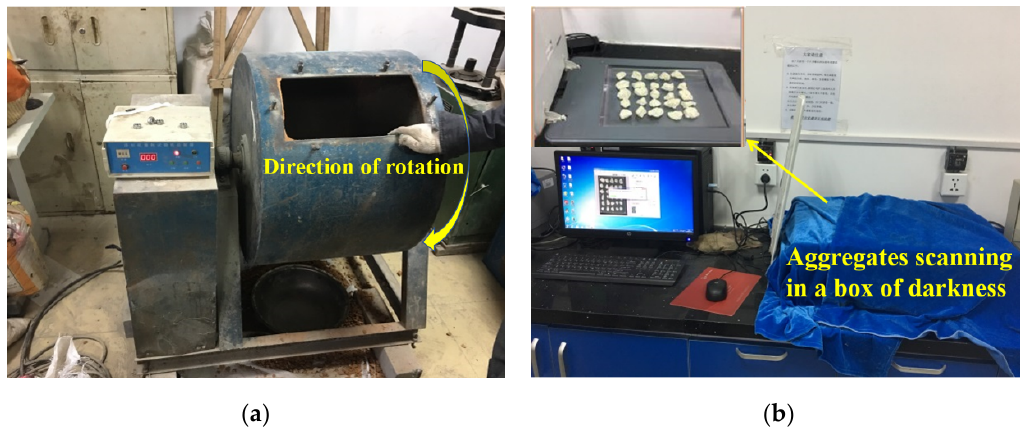
Figure 5. Surface treatment experiment in laboratory: ( a ) Los angles abrasion machine; ( b ) parallel light scanning machine.